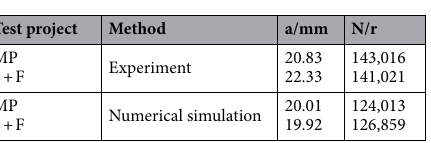
Table 2. Results of experiments and numerical